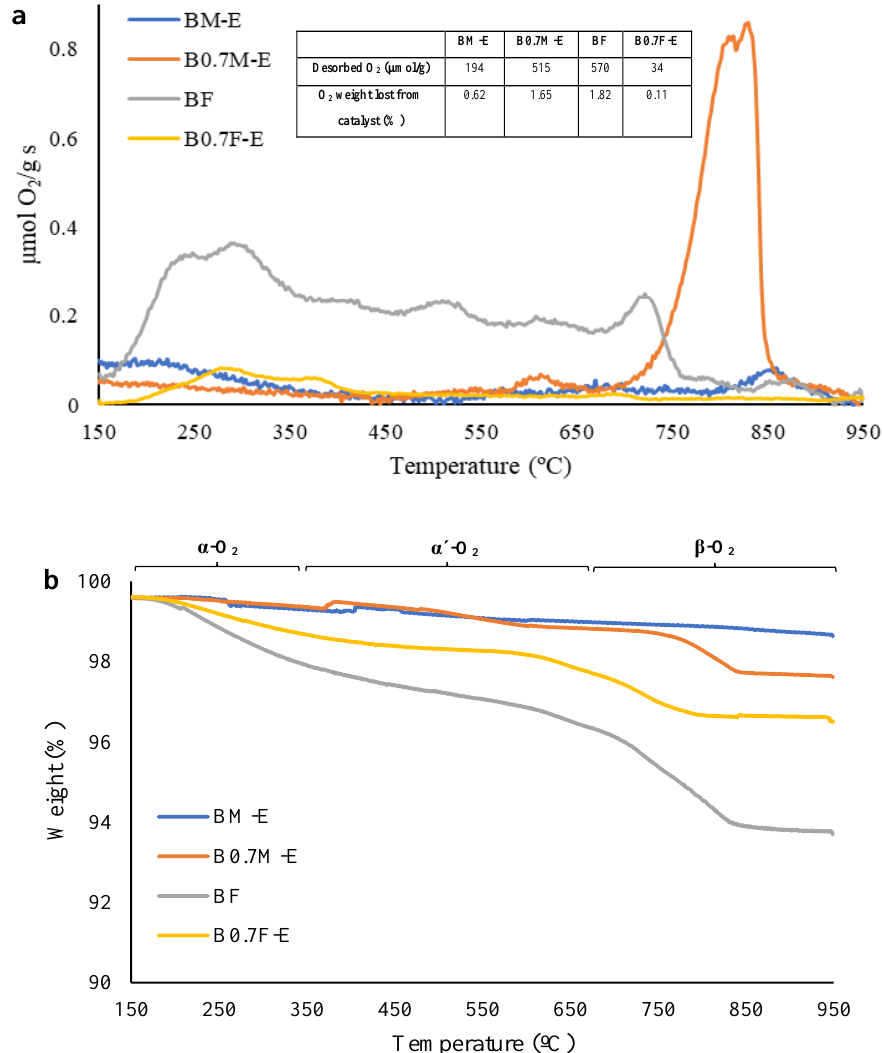
Figure 7. O 2 -TPD profiles ( a ) and weight profiles ( b ) of catalysts.